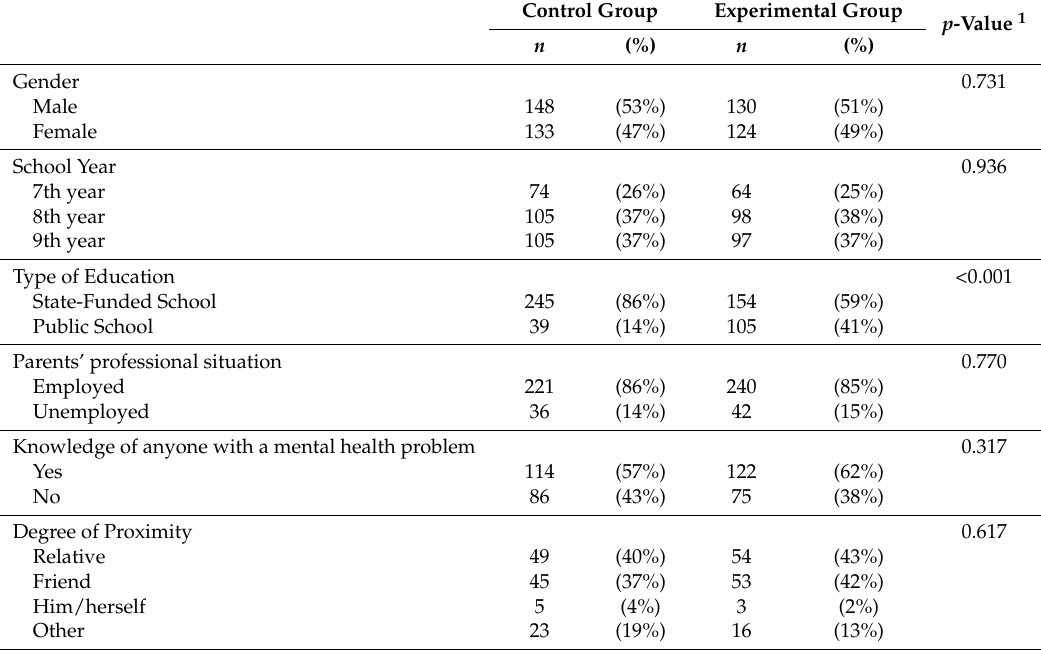
Table 1. Differences between the experimental group and control group regarding sociodemographic variables